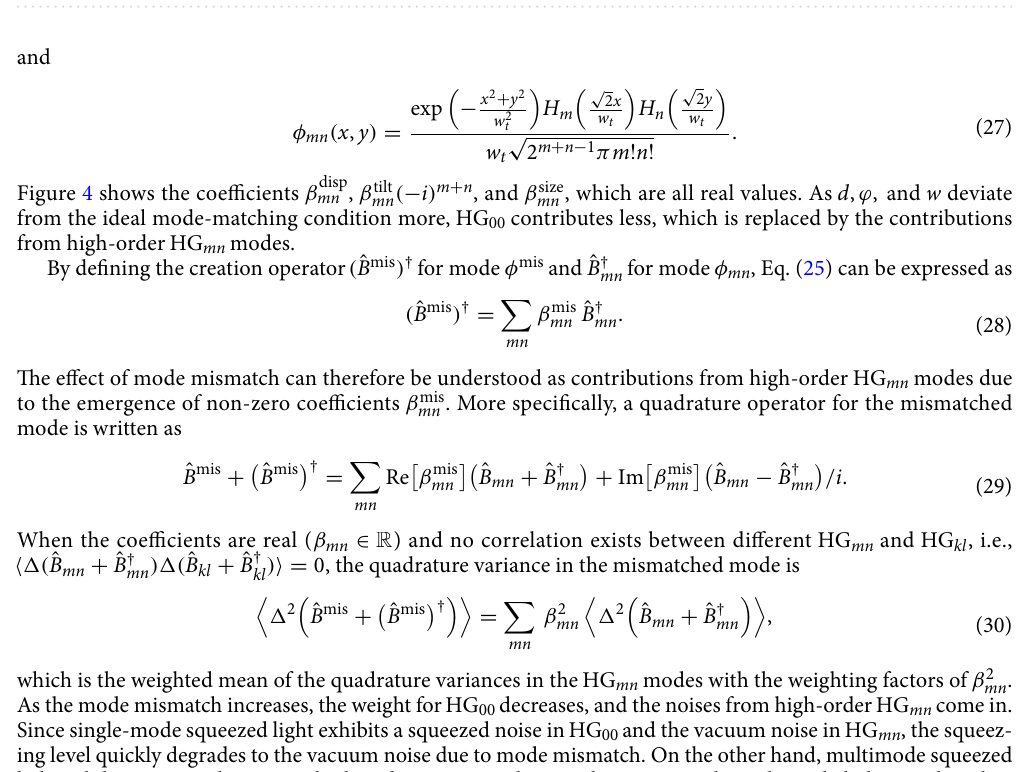
Figure 4. Coefficients arising from mode mismatch: displacement ( β difference ( β size mn ) in ( b ). As mode mismatch increases, the contribution of HG 00 decreases gradually while high- order HG mn contribute more. Dashed lines represent reduction of contribution from HG 00 by 50 % (or 1 / √ 2 for the coefficient) due to mode mismatch, which takes place at d / w t